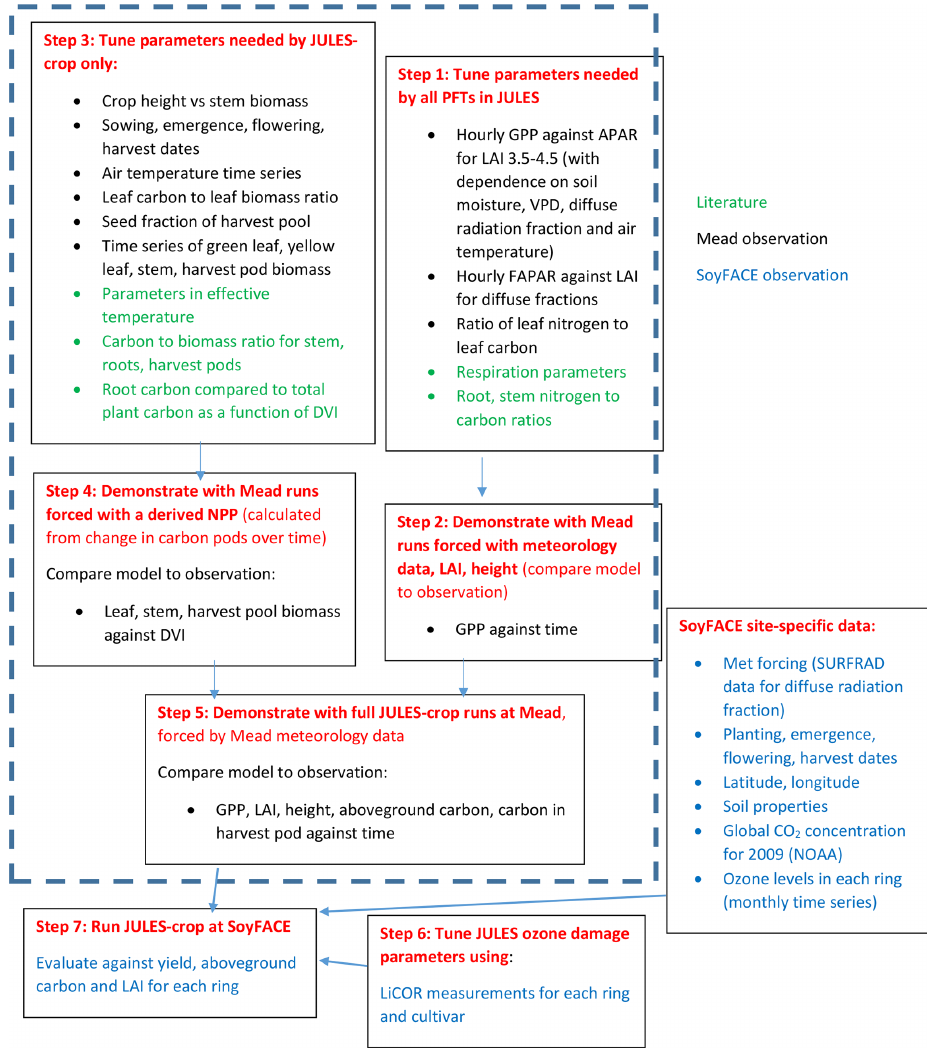
Figure 1. Flowchart of tuning the parameters and calibrating the